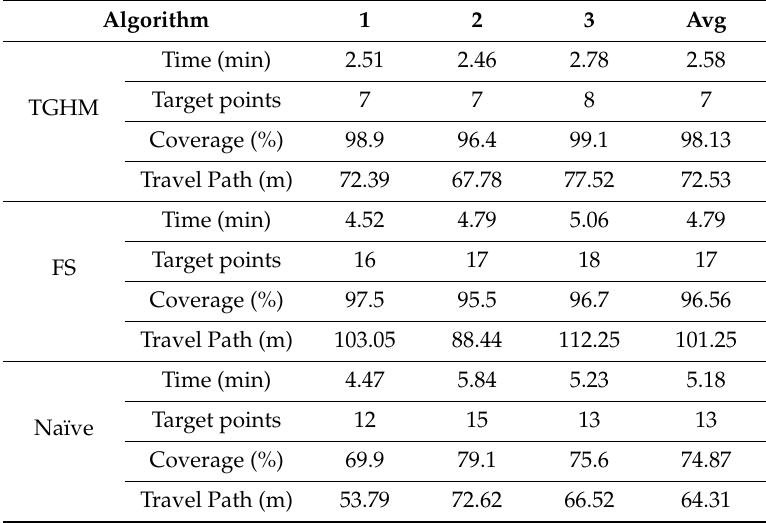
Table 2. Exploration time of each algorithm.